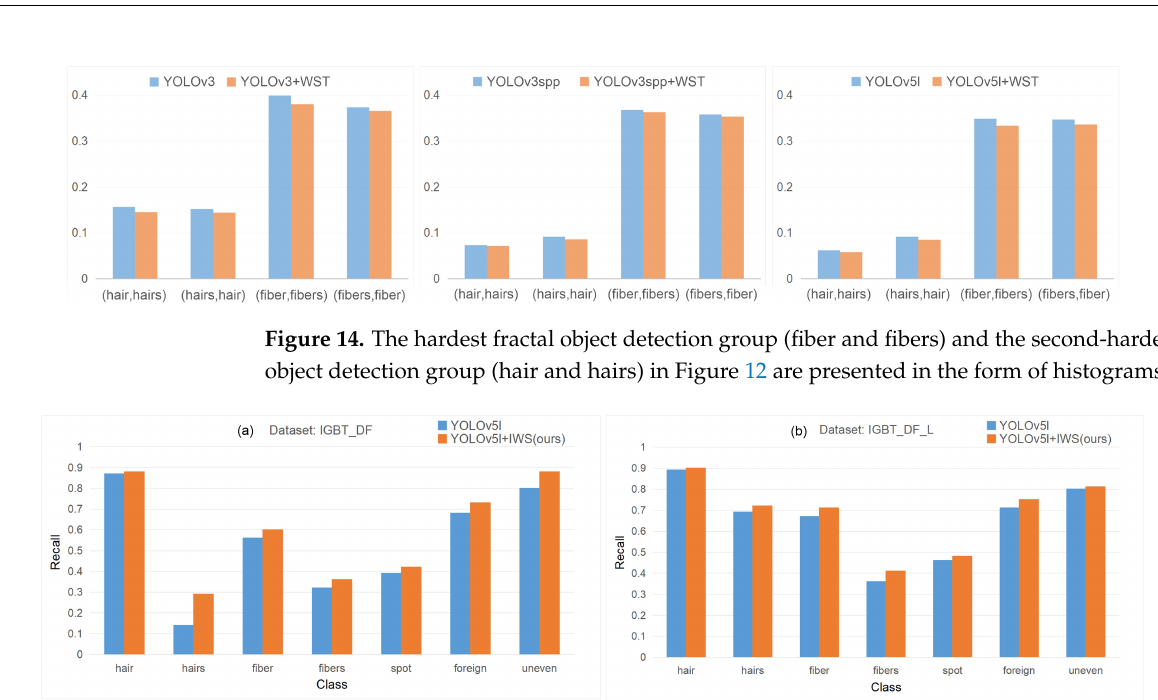
Figure 15. The comparative performance of each class under different scale datasets.